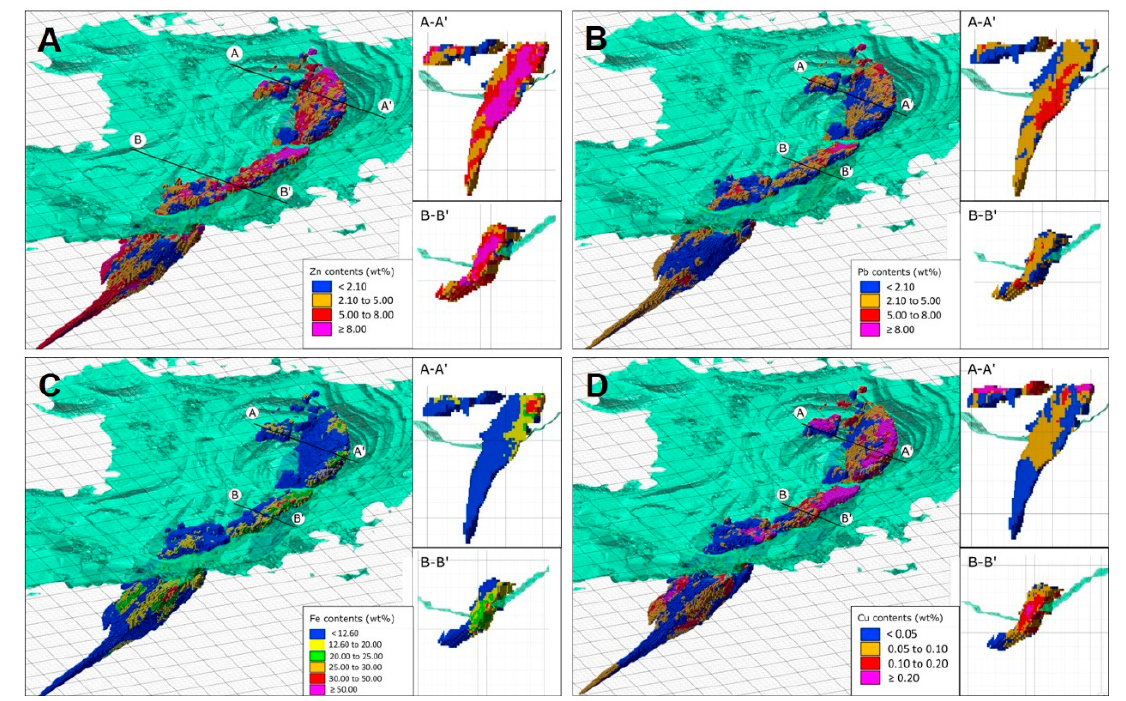
Figure 3. Block model of the Castellanos orebody showing the distribution of Zn ( A ), Pb ( B ), Fe ( C ) and Cu ( D ). Sections A–A’ and B–B’ show local vertical distribution of Zn, Pb, Fe and Cu in the Farallones (A–A’) and Susana (B–B’) blocks.